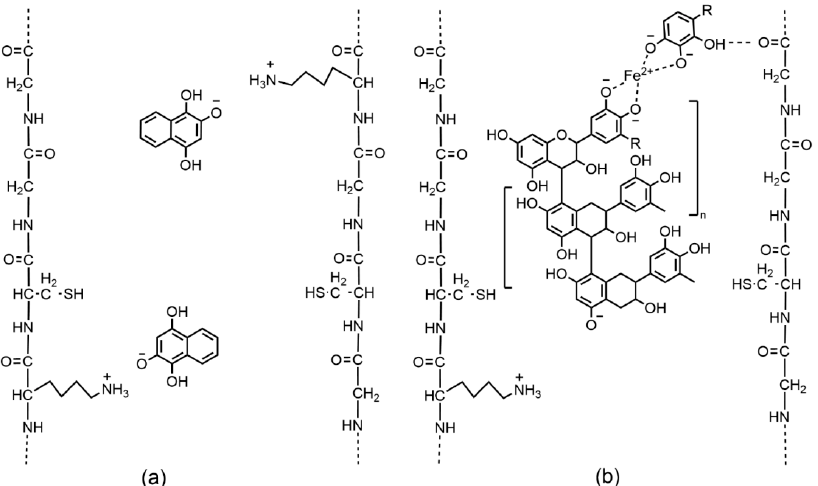
Figure 1. Possible interactions between hair fibers and lawsone ( a ); Possible interactions between hair fiber, polyphenol dye and mordanting iron (II) ions, where R=H, CH 3 , OH ( b ). Reprinted with permission from Ref. [36]. Copyright 2021, Multidisciplinary Digital Publishing Institute.